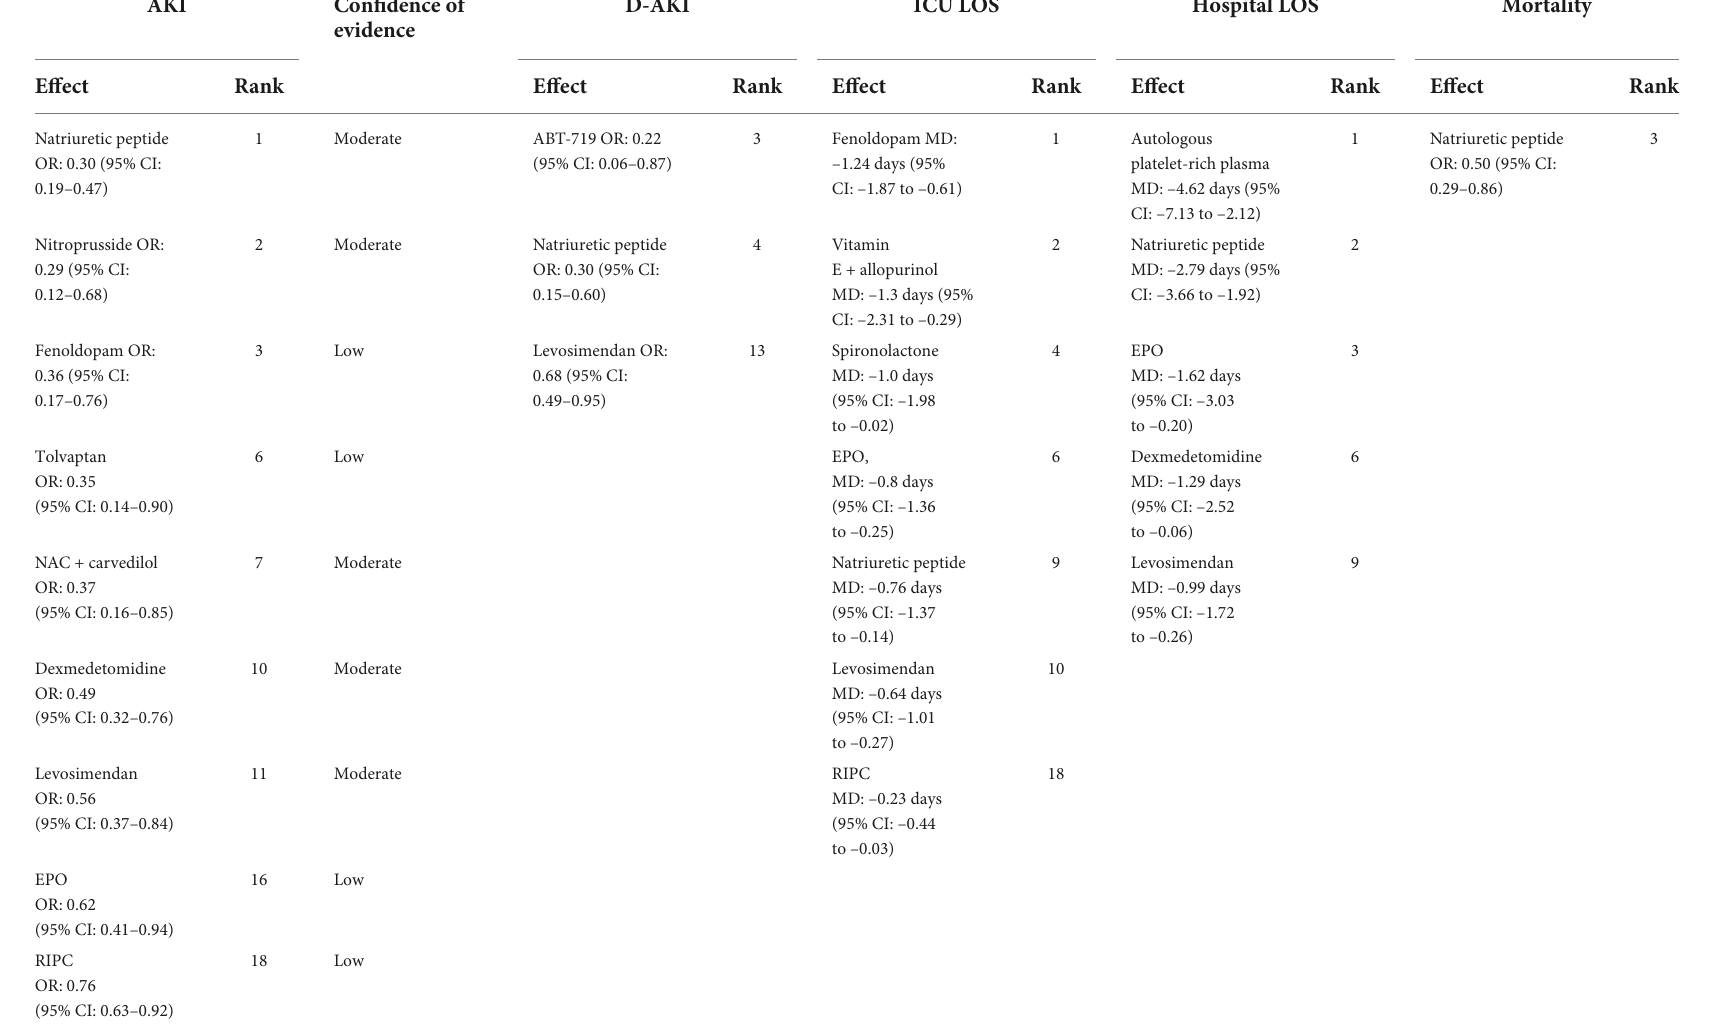
TABLE 1 Summary of potential effective strategies for primary, secondary outcome and rank probability. AKI Confidence of D-AKI ICU LOS Hospital LOS Mortality evidence Effect Rank Effect Rank Effect Rank Effect Rank Effect Rank